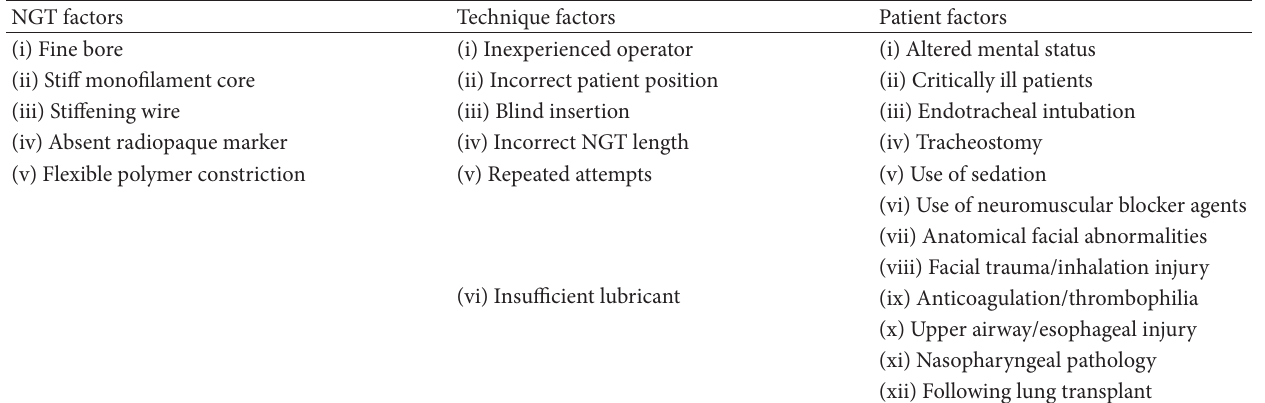
Table 2: Factors increasing the risk of nasogastric tube